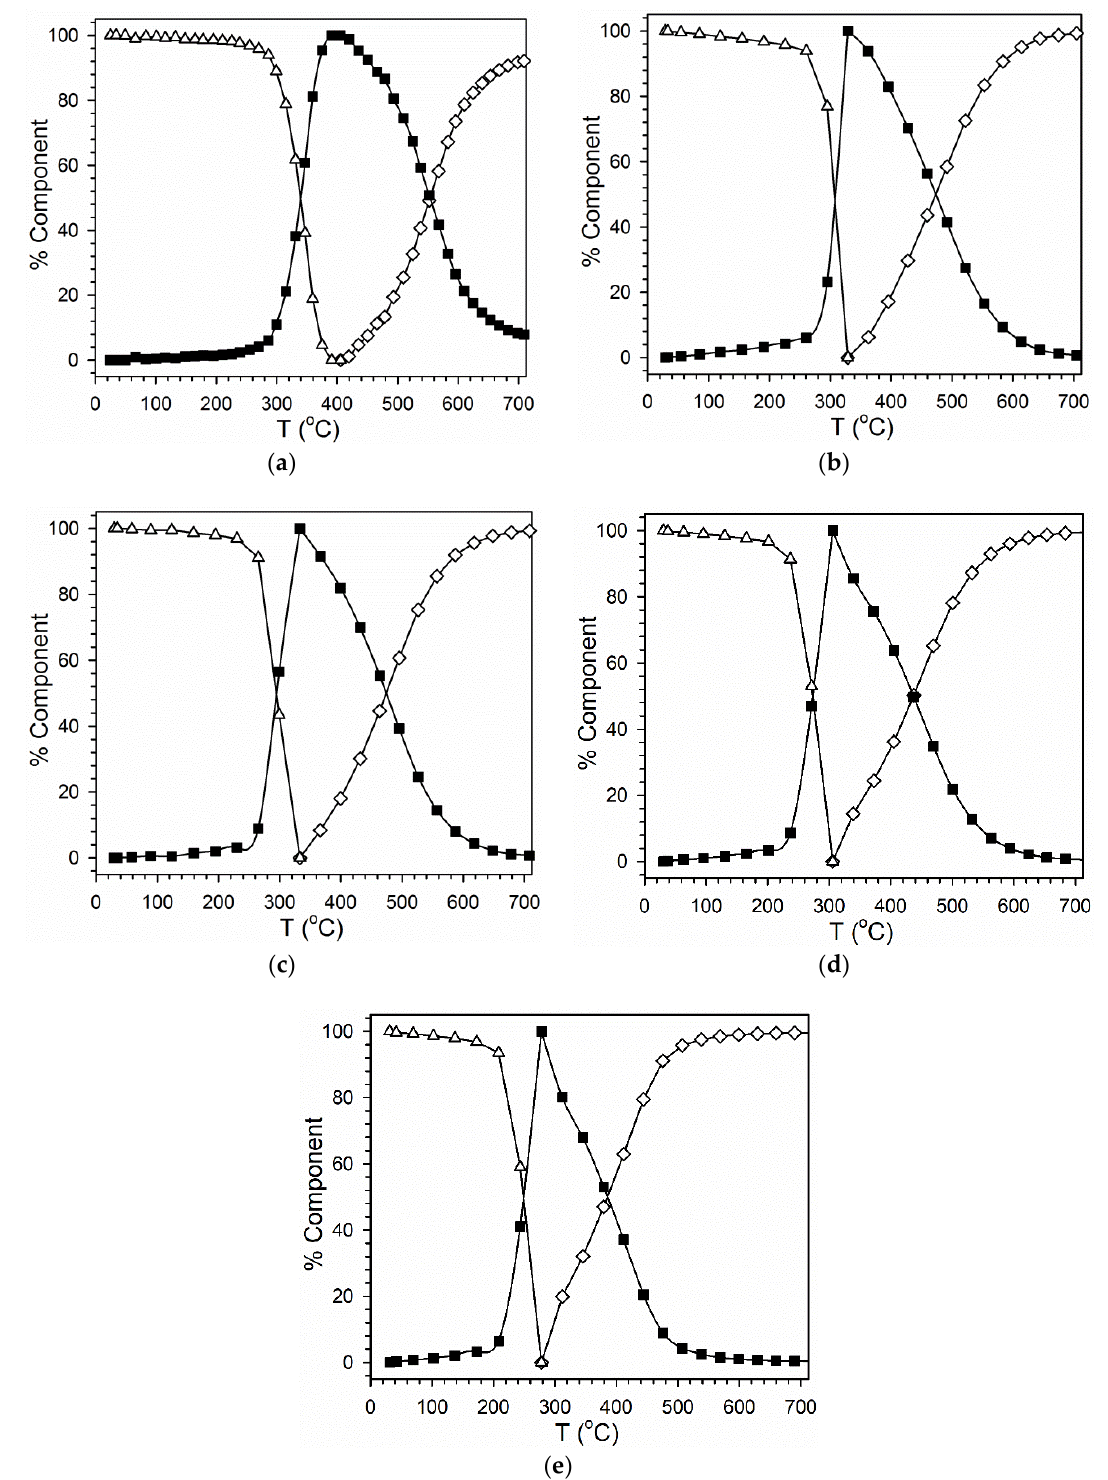
Figure 7. LC fittings of H 2 -TPR-XANES spectra at the Co K-edge of ( a ) 25%Co/Al 2 O 3 , ( b ) 25%M (M = 5%Ni-95%Co)/Al 2 O 3 , ( c ) 25%M (M = 10%Ni-90%Co)/Al 2 O 3 , ( d ) 25%M (M = 25%Ni-75%Co)/Al 2 O 3 , and (e) 25%M (M = 50%Ni-50%Co)/Al 2 O 3 . The point of 50%CoO/50%Co 0 was attained at 553 °C (Ni/Co = 0/100), 473 °C (Ni/Co = 5/95), 473 °C (Ni/Co = 10/90), 437 °C (Ni/Co = 25/75), and 386 o C (Ni/Co = 50/50). Thus, up to a 167 °C decrease